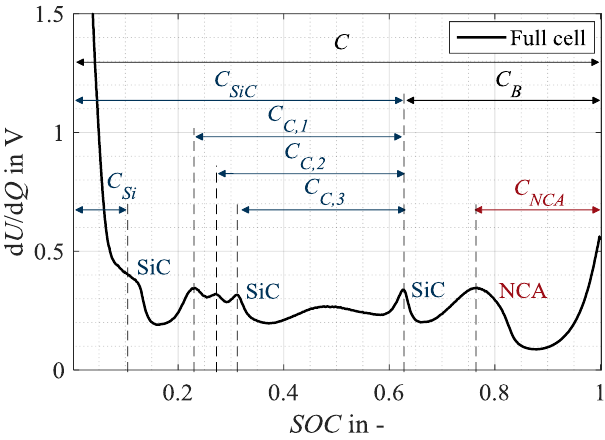
Figure 2. Assignment of distinct characteristic capacities in the DVA spectra (in charge direction) of the full cell in 18650 format as a basis for the evaluation of present aging mechanisms and modes.